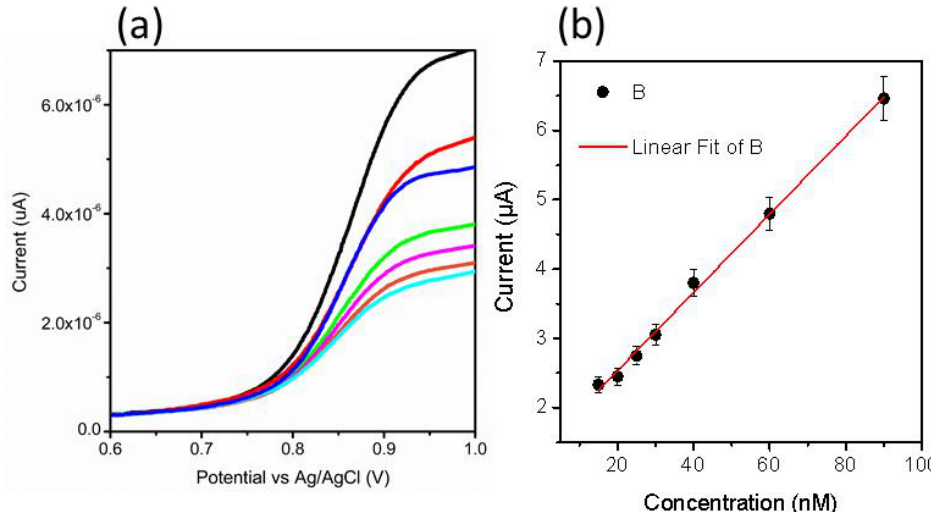
Figure 4. ( a ) LSV curves measured at 50 mV/s for different concentrations 15–90 nM of MTX in a 0.04 M BRB buffer of pH 2 and ( b ) linear plot of oxidation peak current versus different concentrations of MTX.